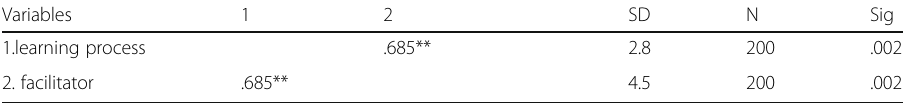
Table 3 Correlational Analyses between Epistemological Belief and Teaching Style